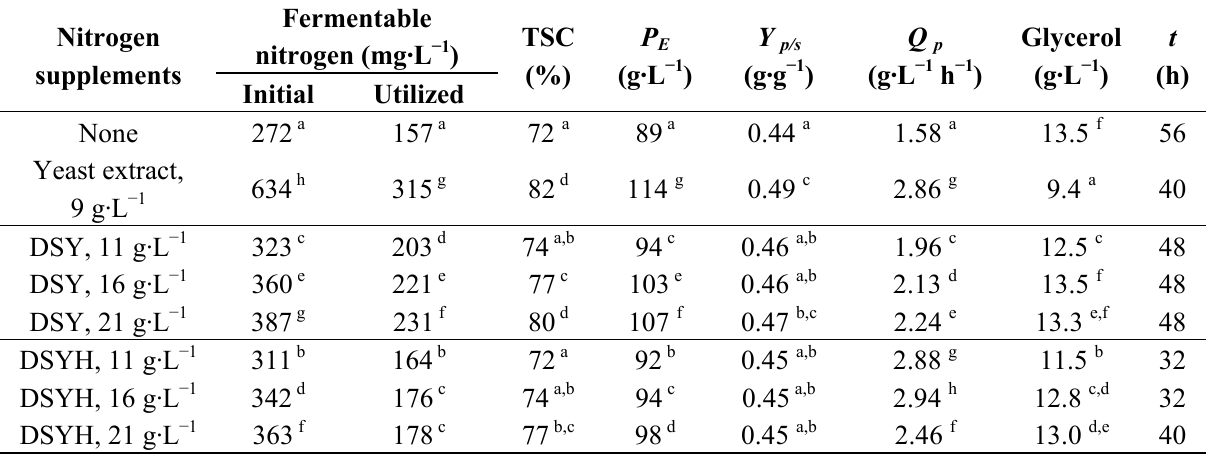
Table 2. Fermentable nitrogen utilization and main fermentation parameters of single batch ethanol production from sweet sorghum juice containing 280 g·L − 1 of total sugar under various nitrogen